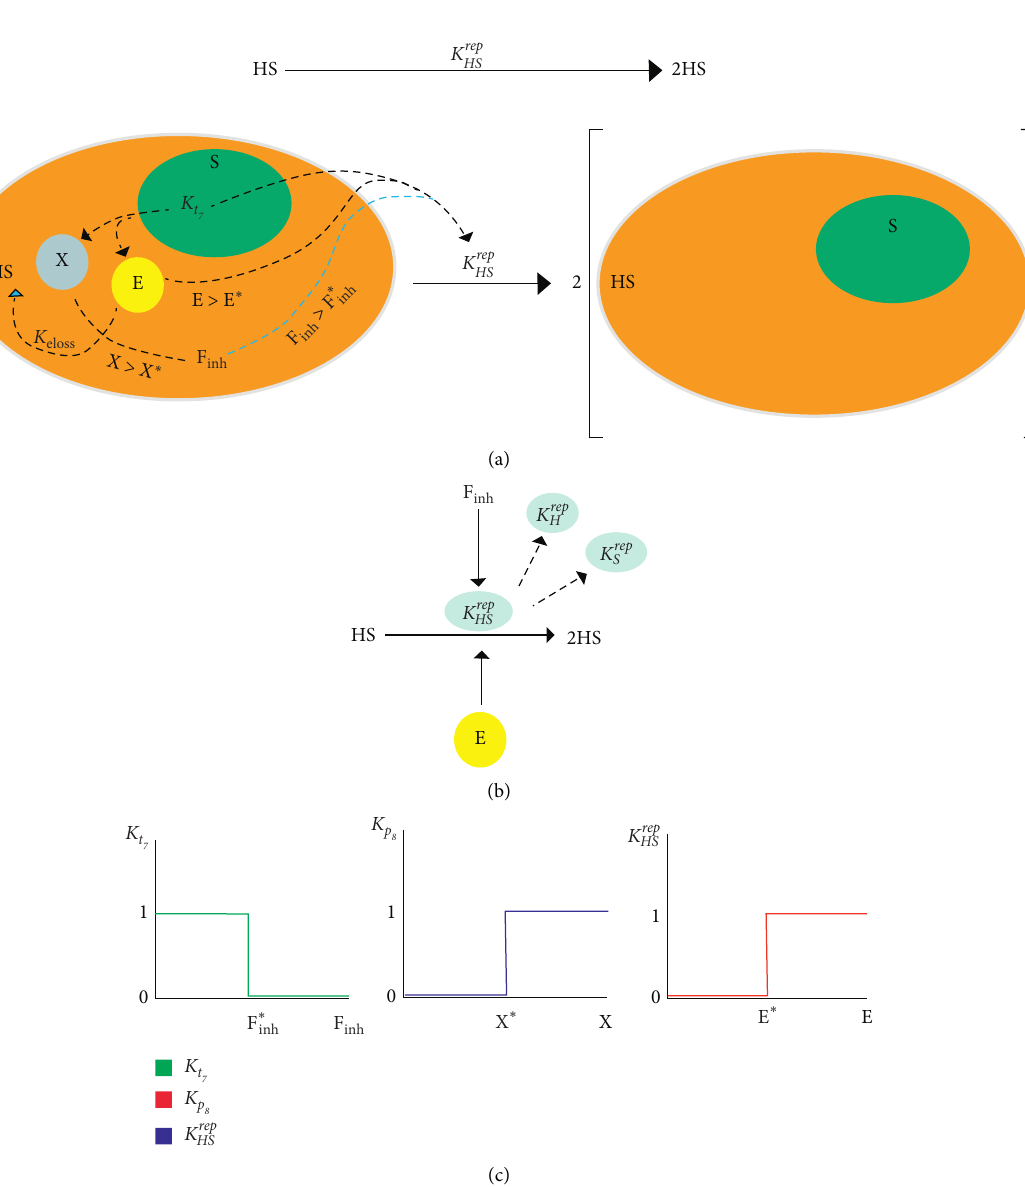
, and how E , x , and F affect the kinetic parameter k rep inh 4 > F ∗ . Blue dotted line represents the release of inhibition factors by coral inh inh